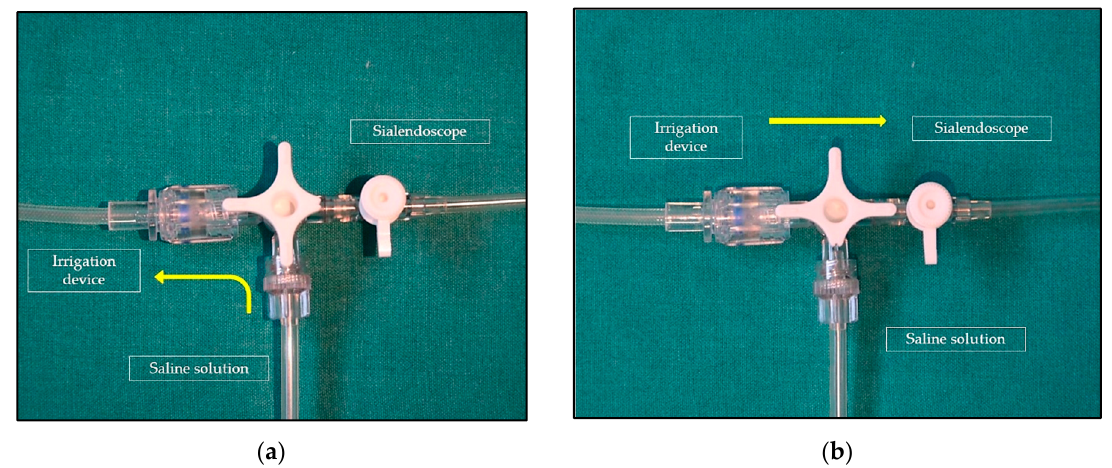
Figure 3. ( a ) The three-way stop-cock is positioned so as to allow saline to flow from the bottle to the syringe of the device, which can be filled with 20 cc of solution. ( b ) Once the syringe is filled with saline, the device is locked and the three-way stop-cock is rotated to allow fluid to pass from the syringe to the sialendoscope ( b ). The yellow arrows indicate the direction of the saline solution.